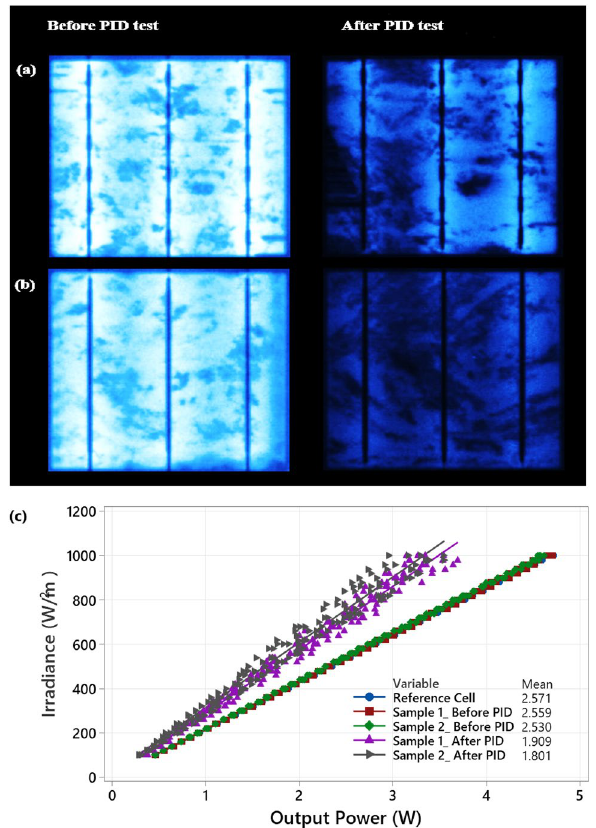
Figure 9. PID test output results ( a ) Sample #1, ( b ) Sample #2, ( c ) Output power measurements before and after the PID test was performed.